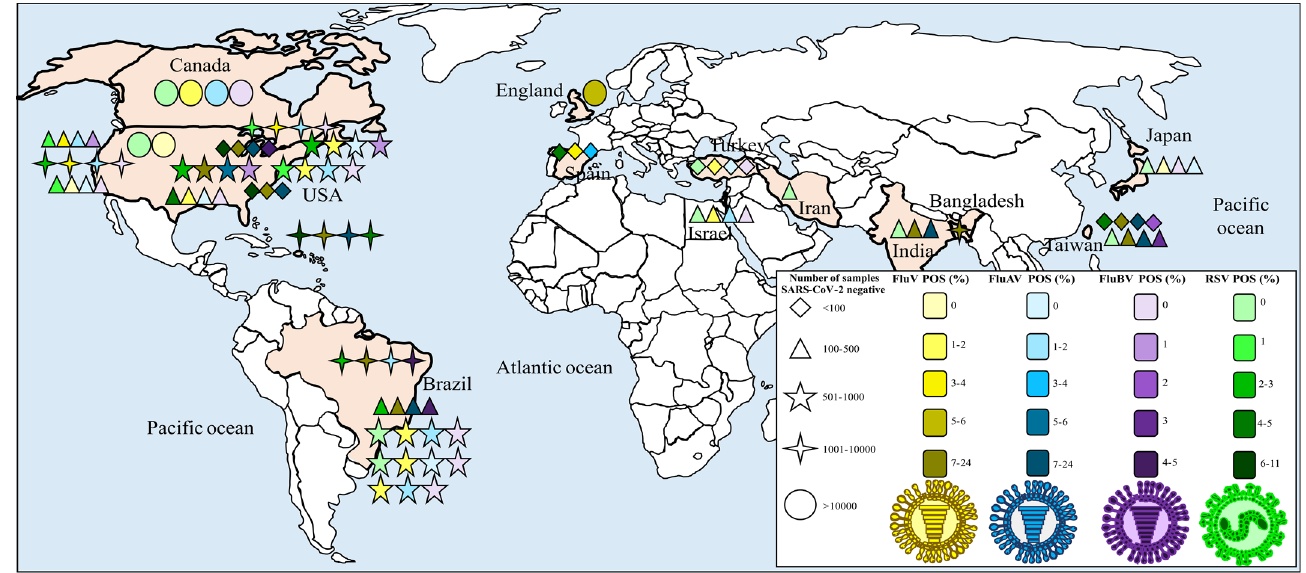
Figure 4. Map illustrating the geographical distribution of the included studies containing positivity values for FluV and RSV.